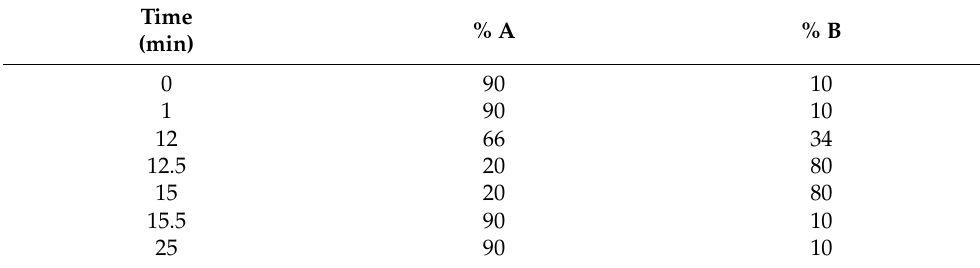
Table 7. Mobile phase concentration gradient.